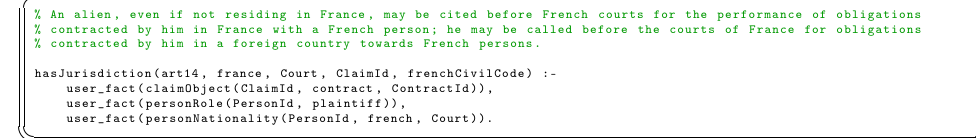
Figure 12. French Civil Code Prolog